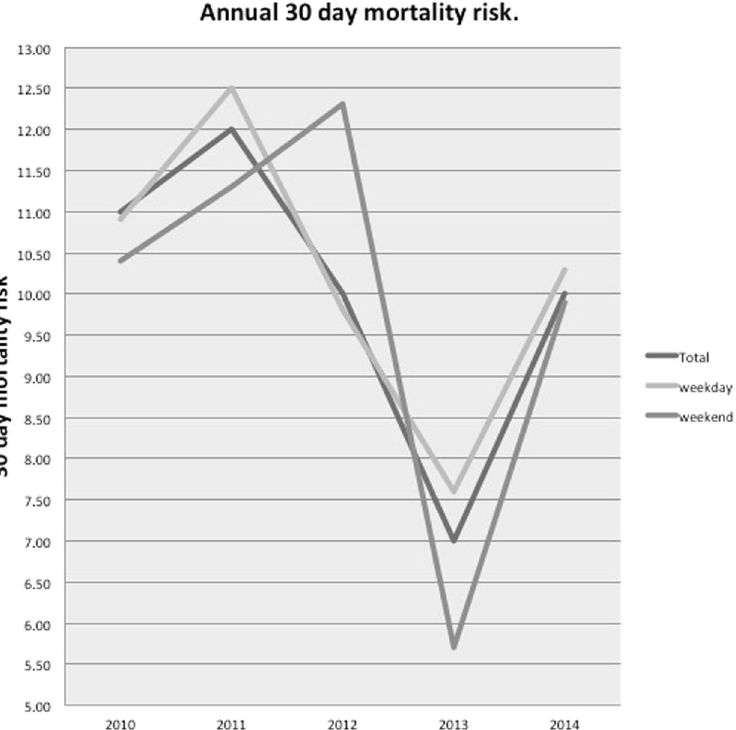
Figure 1. A line chart showing the yearly 30-day mortality risk of all patients, weekday admission and weekend admissions. Weekend mortality is lower than weekday with the exception of 2012.